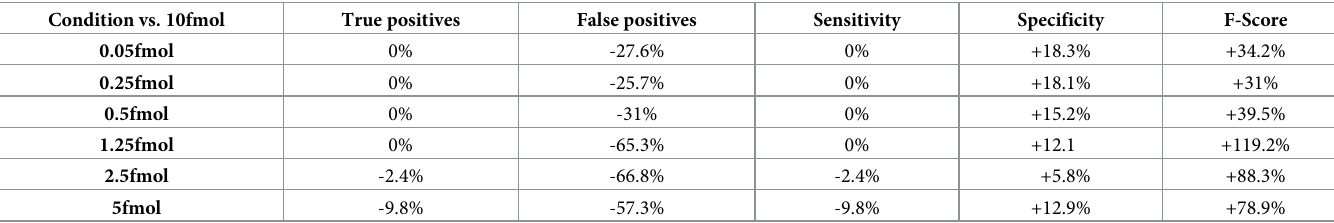
Table 6. Performance of the mi4p methodology (with the aggregation step) expressed in percentage with respect to DAPAR workflow, on Arabidopsis thaliana + UPS1 experiment, with at least 1 out of 3 quantified values in each condition. Missing values were imputed using the Maximum Likelihood Estimation method. Condition vs. 10fmol